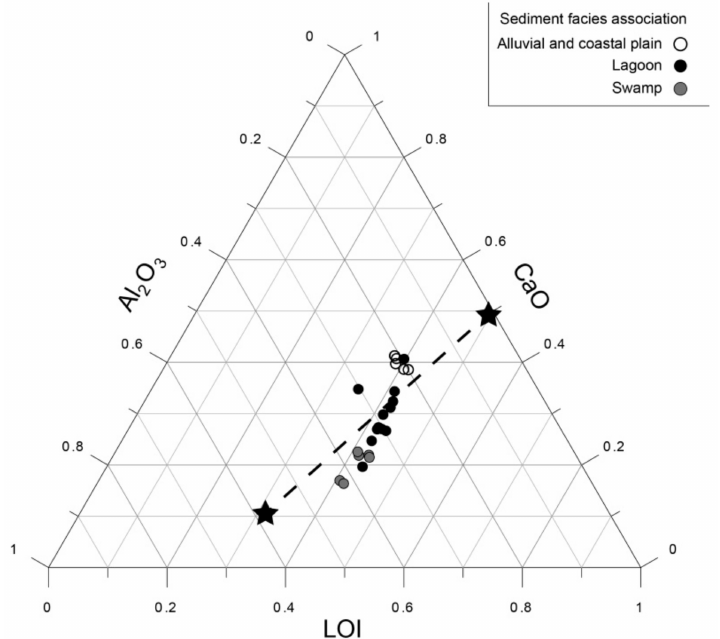
Figure 8. Ternary plot of CaO, Al 2 O 3 , and LOI in accordance with [36] used to assess organic matter enrichment from core 240 S5 [25]. Points located below the average pelite (lower star)–carbonate (upper star) composition line suggest high organic matter